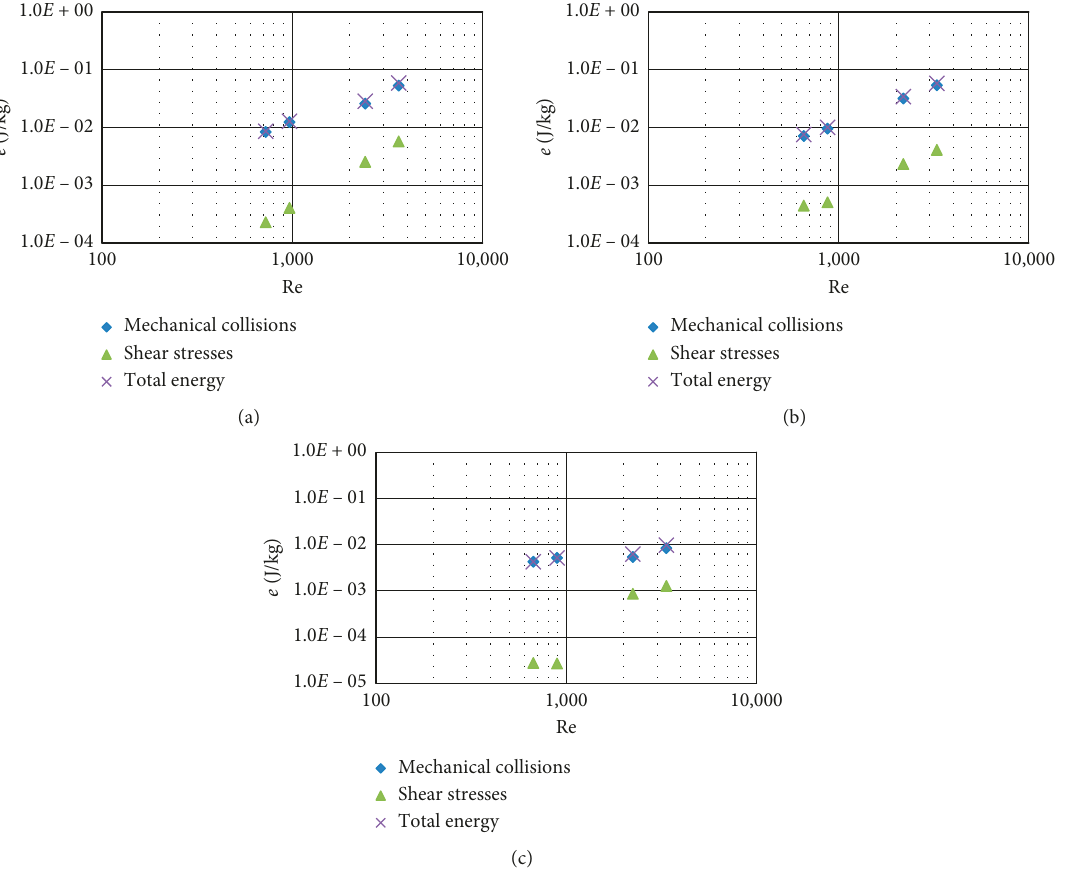
Figure 23: The contribution of individual destruction sources in the total unit energy: (a) Kenics static mixer; (b) Koflo static mixers; (c) pipe.